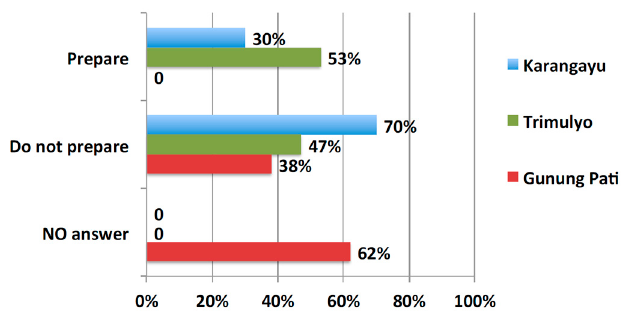
Figure 5. Flood preparedness, as percent of participants from each case study area.